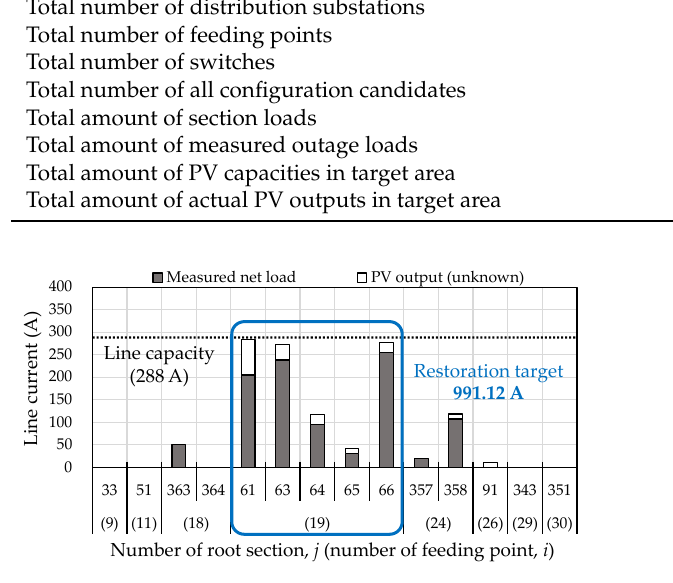
Figure 6. Line currents in normal condition.